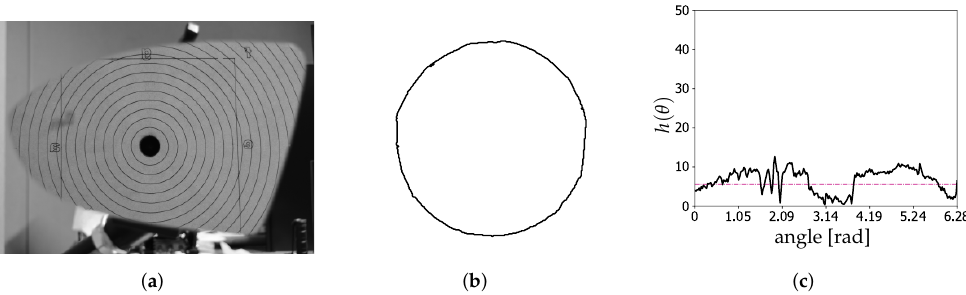
Figure 12. Representative calculation the distortion factor of M1. ( a ) Reflected circular pattern. ( b ) Extraction of the first circle. ( c ) Distribution of the difference between the extracted circle and the ideal one.